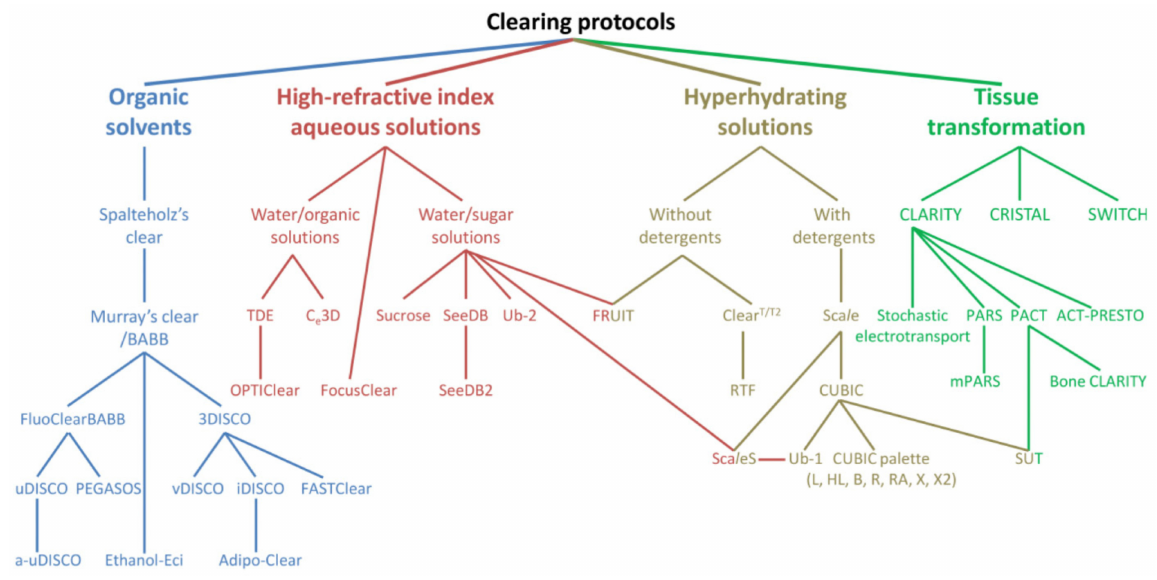
Figure 1. Arborization of the family of TOC protocols. The diagram represents four broad, chemical categories of TOC along with major TOC techniques. Reproduced from Matryba et al. [19] under the terms of the Creative Commons CC-BY-NC